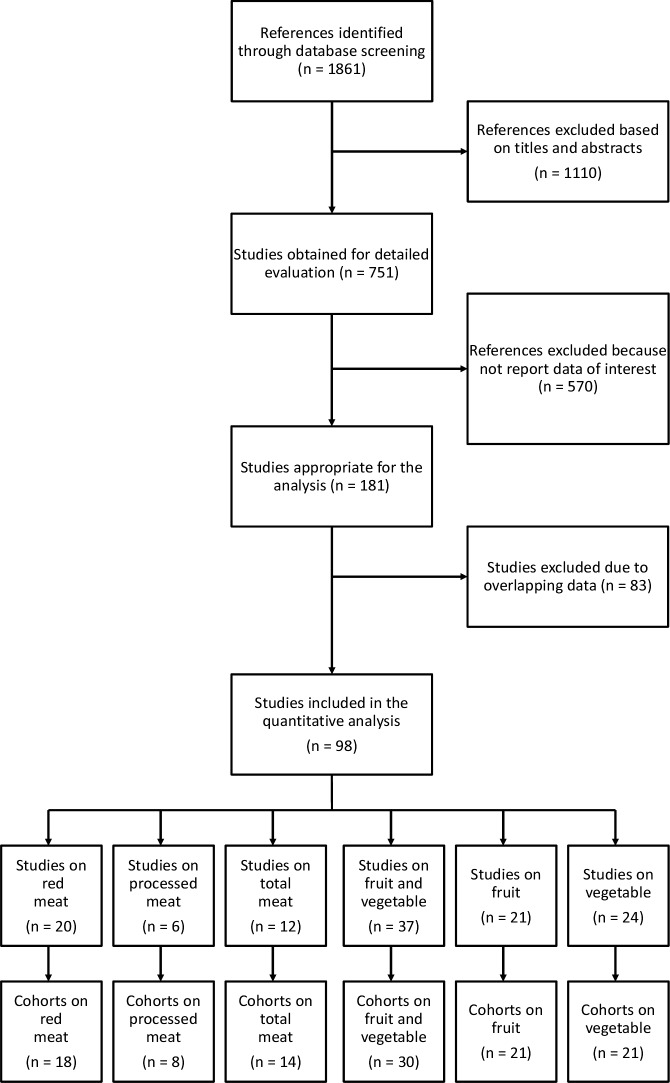
Screening and selection process of the study articles exploring the association between meat, fruit, vegetable consumption and cancer risk.